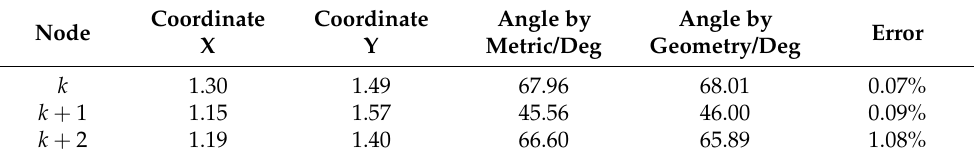
Table 5. Comparison between the mapping-based method and geometrical method.